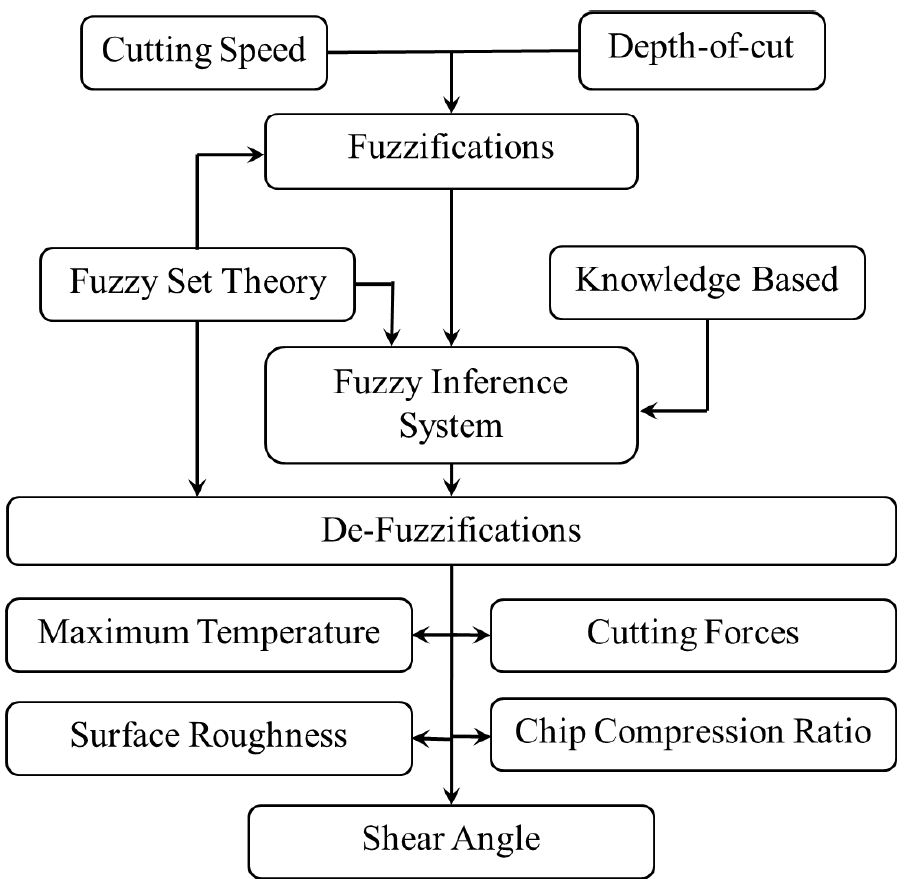
Figure 1. Schematic illustration of developed fuzzy inference systems for CT and